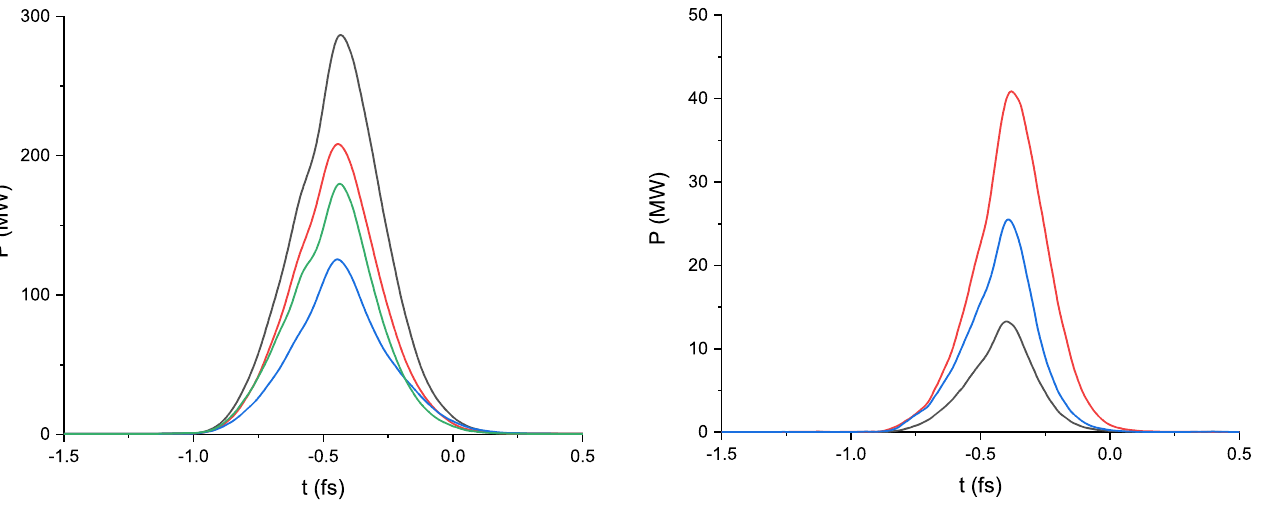
FIG. 6. Radiation power for three representative shots at 2.4 nm. Bunch head is on the left side.